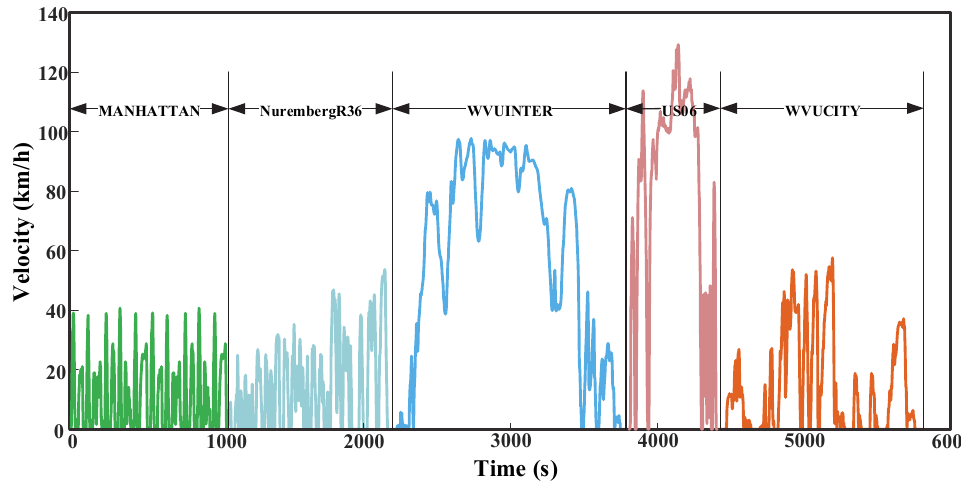
Figure 8. Comprehensive driving cycles.